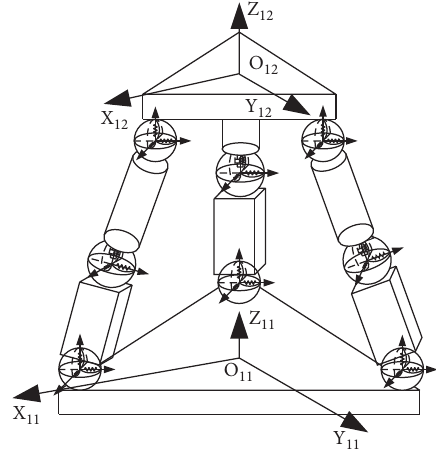
Figure 10: 3D model of parallel